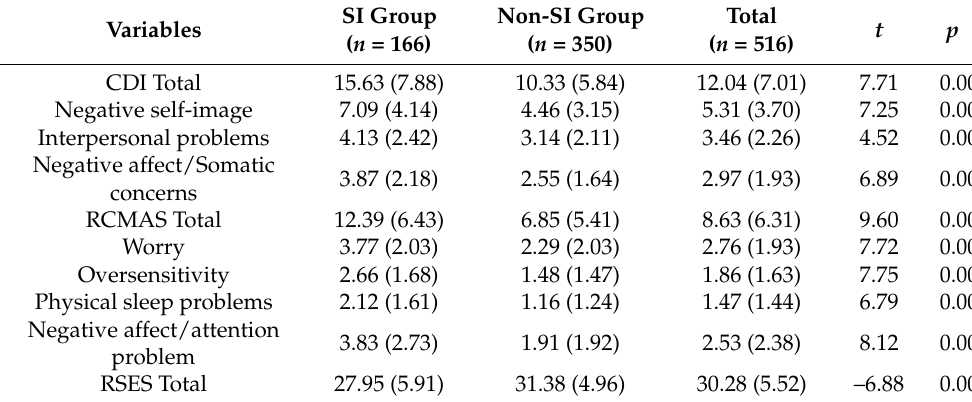
Table 6. Group differences in psychological